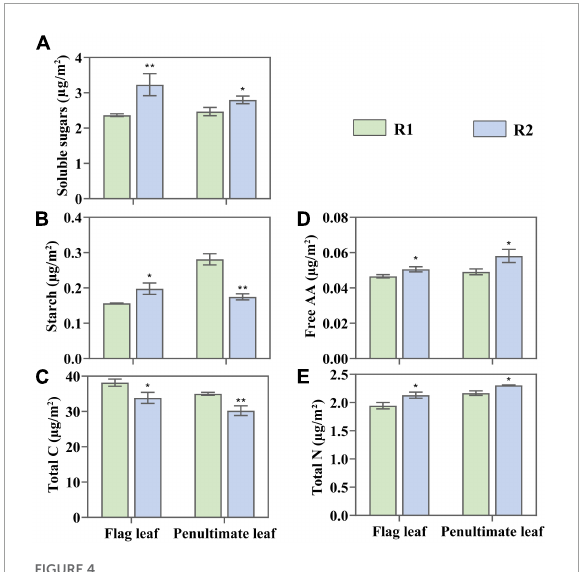
FIGURE4 Change in soluble sugar (A) , starch (B) , total carbon (C) , free amino acid (AA) (D) , and total nitrogen (E) in the flag and penultimate leaves at anthesis under different row spacing treatments. Results expressed as mean ± standard deviations (SD) and the error bars represent SD. Significant differences marked by asterisks (* p < 0.05; ** p <